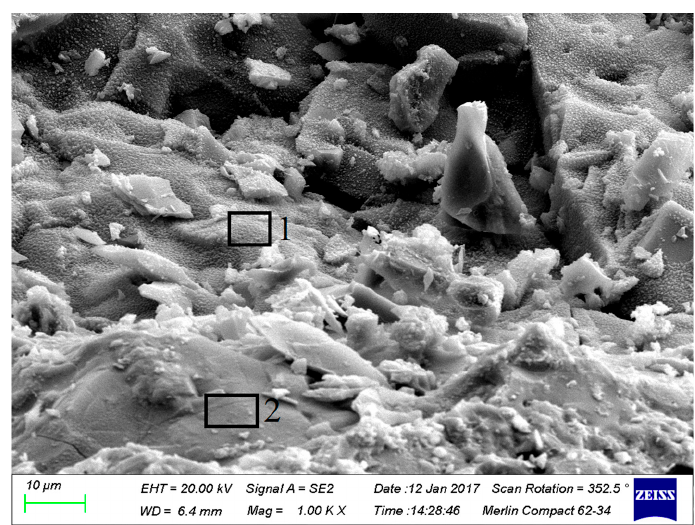
Figure 9. Scanning electron microscope (SEM) image of AASC with a silicate modulus of 1.2 and Na 2 O content of 8% after 28 days.